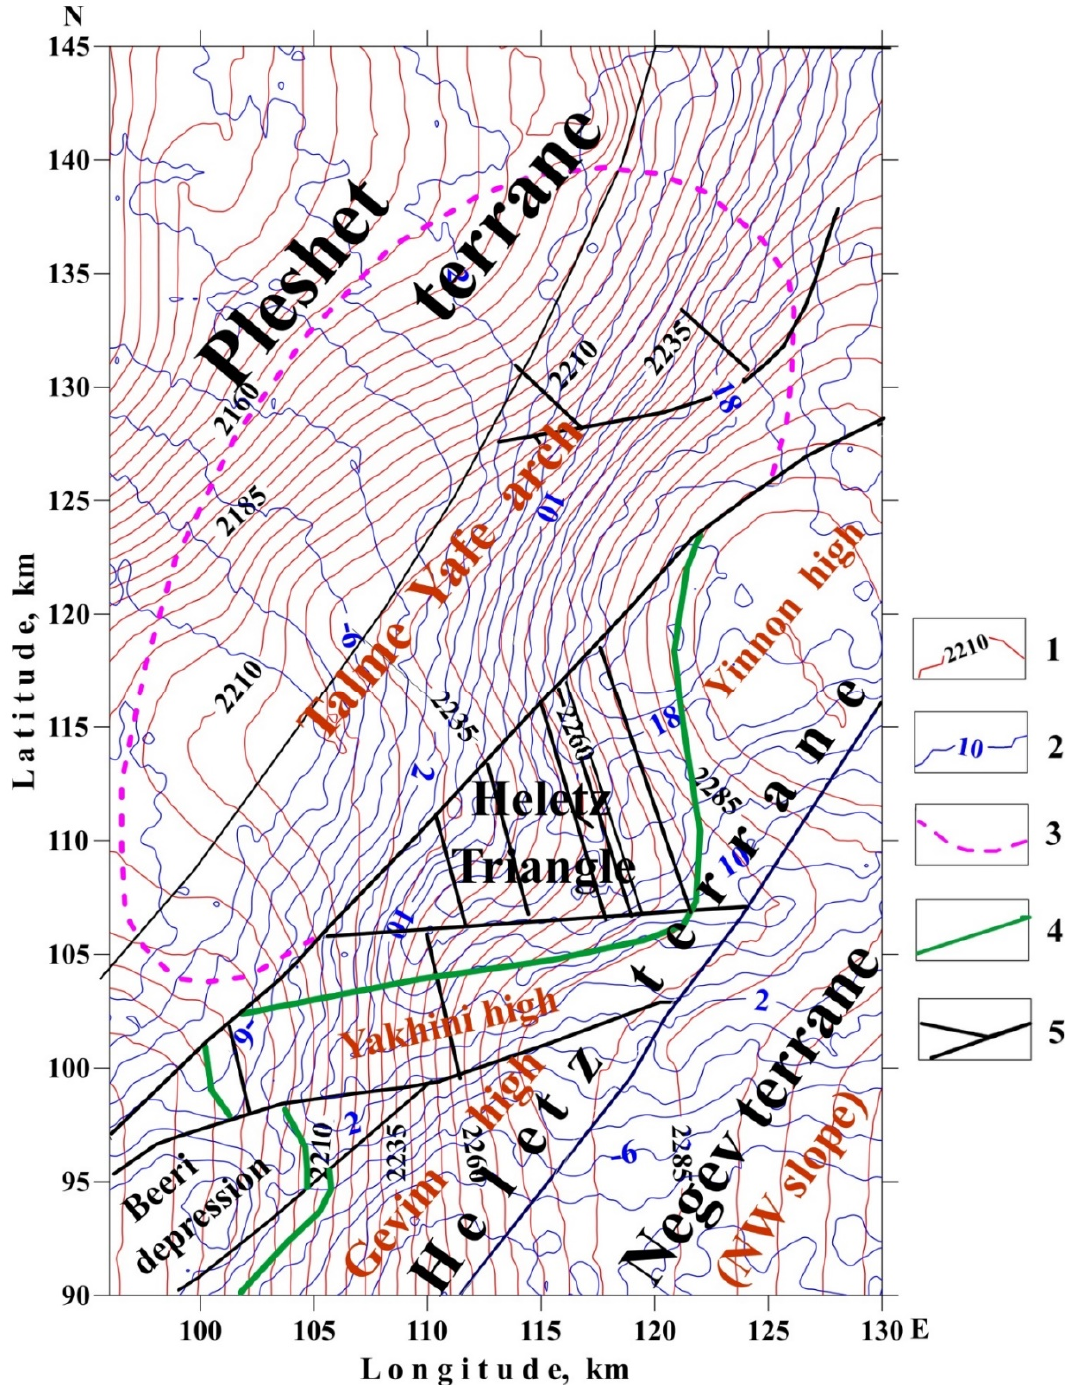
Figure 13. Combined gravity-magnetic map overlaid on the Late Jurassic-Early Cretaceous paleo- tectonic structure of the Heletz–Ashdod oil field and adjacent areas (revised after [7]). (1) Bouguer anomalies isolines (in mGal), (2) isolines of magnetic anomalies (in nT), (3) isopach 800 m of the Middle-Upper Jurassic rocks in the Pleshet terrane, (4) isopach 1300 m of the Middle-Upper Jurassic rocks in the Heletz terrane, (5) faults. The gravity and magnetic maps were constructed using the Gravity-Magnetic DB of Israel [37].